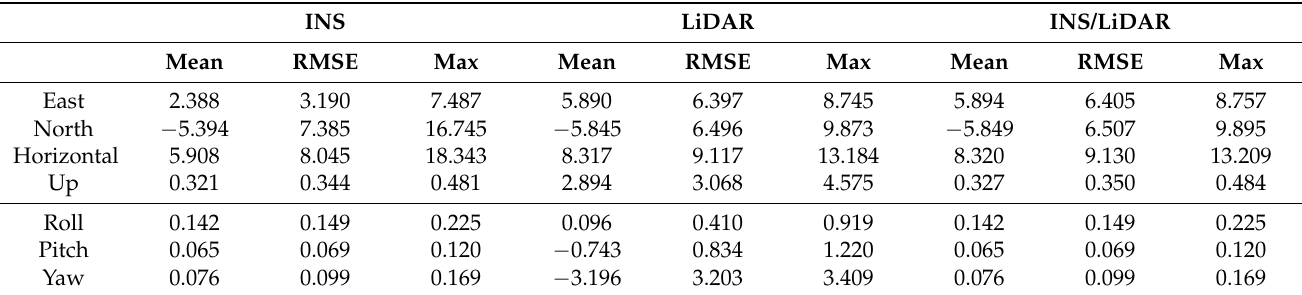
Table A18. D-04—position (m) and attitude (deg) error statistics.